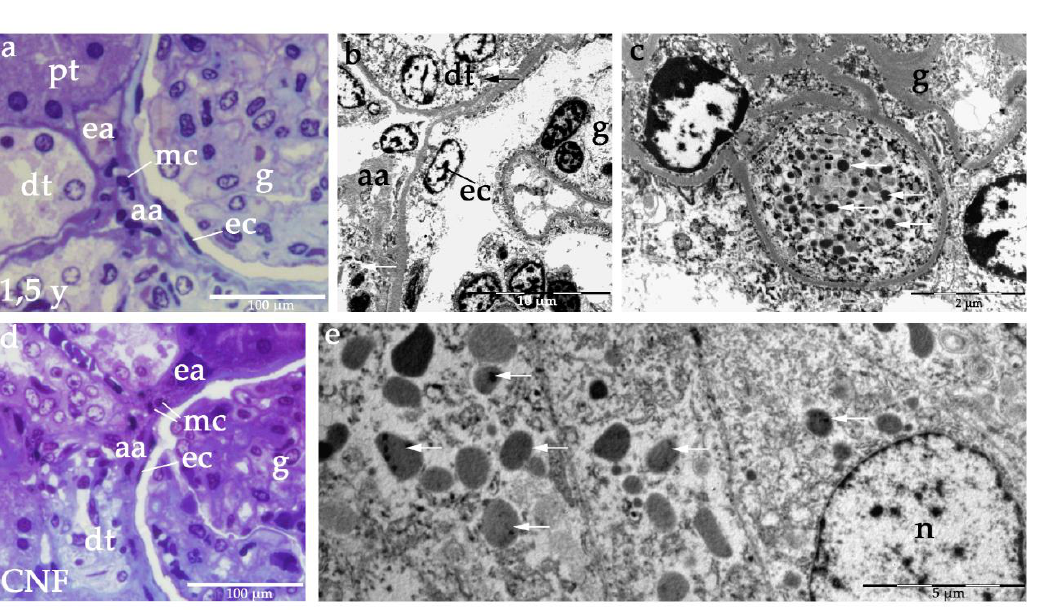
Figure 8. Toluidine blue staining semi-thin section ( a ) and electron microscopy of JGA region of heathy postnatal kidneys ( b ) shows characteristic JGA structures: distal tubule (dt), proximal tubule (pt), afferent arteriole (aa), efferent arteriole (ea), extraglomerular mesangial cells (mc), glomeruli (g), parietal epithelial cells (ec). Note renin granules (arrows) in dt and aa, as well as in some glomerular cells ( c ). Toluidine blue staining semi thin section of JGA region in CNF ( d ) is showing the same histological structures. Electron microscopy shows dense accumulations of renin granules in macula densa of CNF kidneys ( e ). Scale bars: 100 μm ( a , d ), 10 μm ( b ), 2 μm ( c ), 5 μm ( e ).